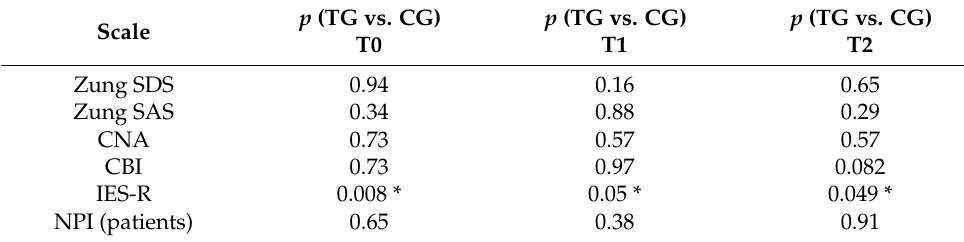
Table 2. Between-group analysis at the three timepoints.